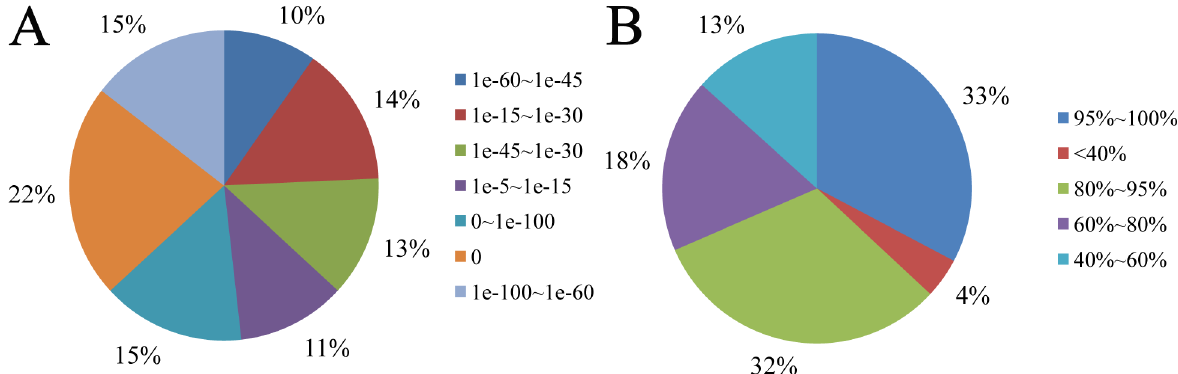
Fig 1. Unigene distribution in the C . idella . (A) E-value distribution of unigenes annotated into public databases with an E-value cut-off of 1E-50. (B) Identity distribution of unigenes annotated into public databases with an E-value cut-off of